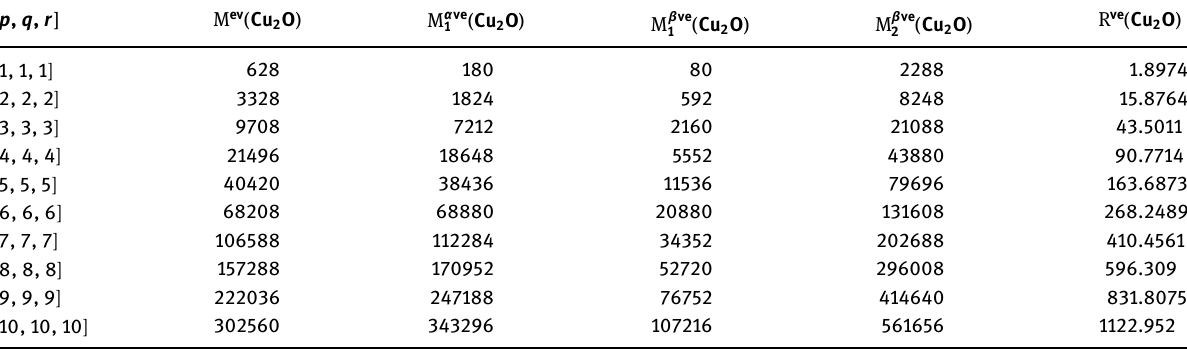
Table 4: Numerical representation of the computed indices for certain values of Cu O